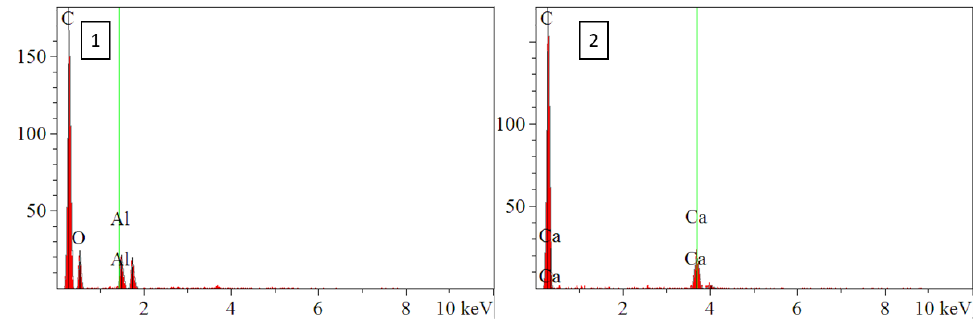
Figure 4. ( a ) FE SEM image of ABS w/CNT. Numbered areas in ( b ) underwent EDS analysis.